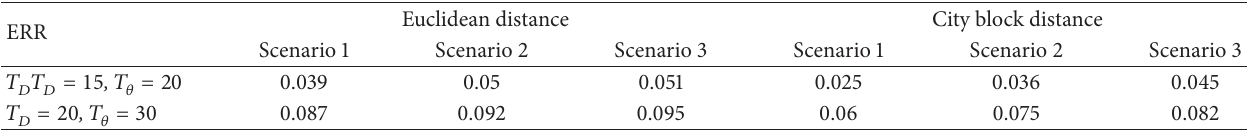
Table 7: Accuracy performance of the proposed